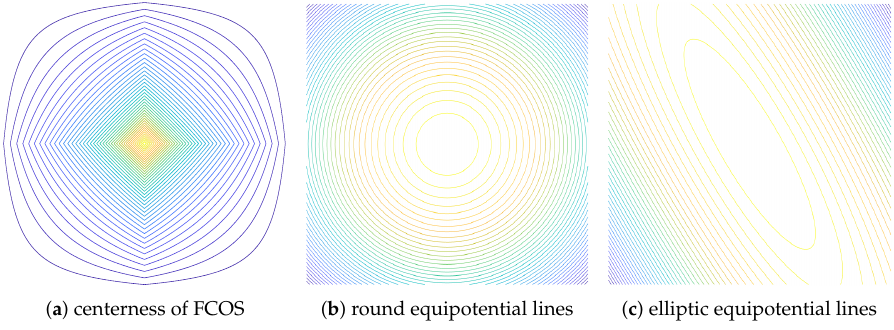
Figure 4. The equipotential line of the weight